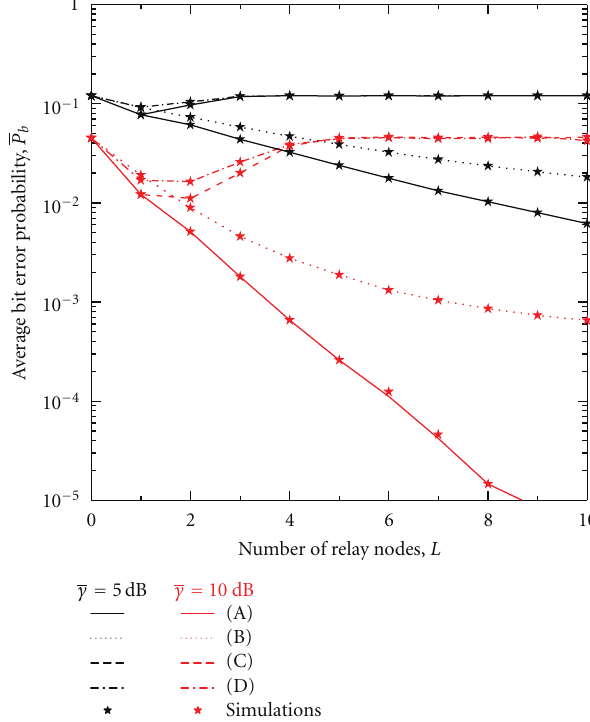
Figure 7: ABEP, P b , of DBPSK versus the number of relay nodes, L , for di ff erent average transmit SNRs per bit and γ = 5dB and γ = 0dB b 0 IID Rayleigh fading channels: (A) pure RS, (B) rate-selective RS, (C) repetitive transmission with MRD, and (D) repetitive transmission with SD.